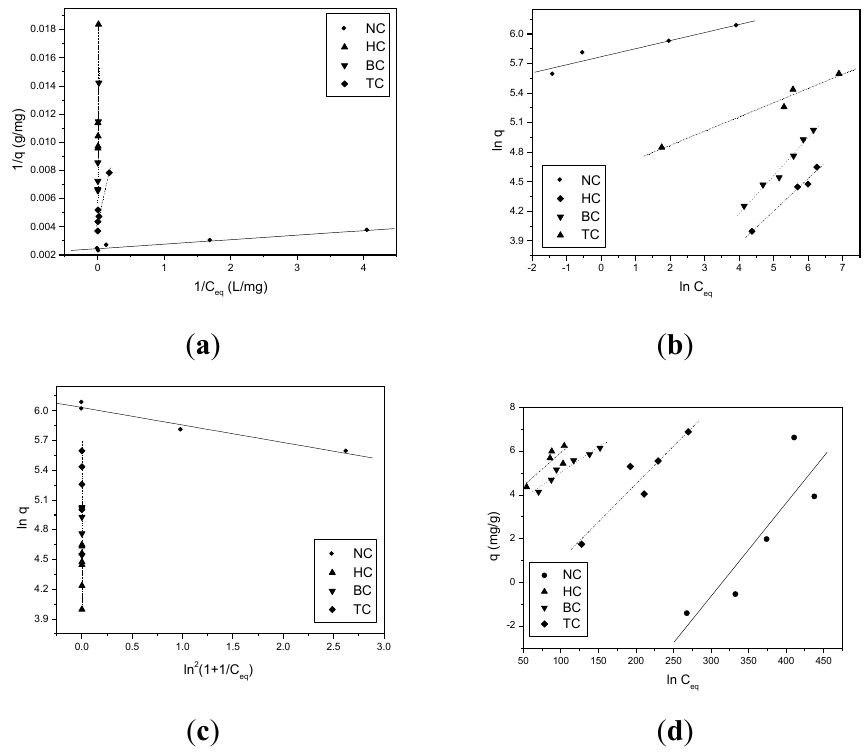
Figure 3. Linearization of the Isotherms for sorption of MB onto the adsorbents: Langmuir ( a ); Freundlich ( b ); Dubinin-Radushkevich ( c ); and Temkin ( d